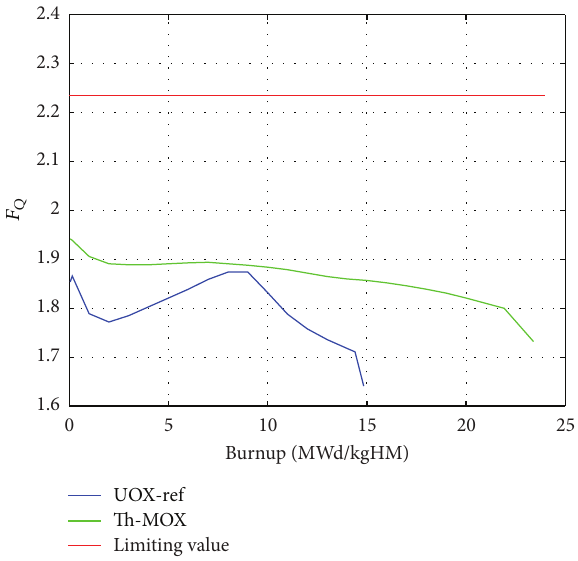
Figure 6: 𝐹 𝑄 , that is, local power relative to core average power as a function of